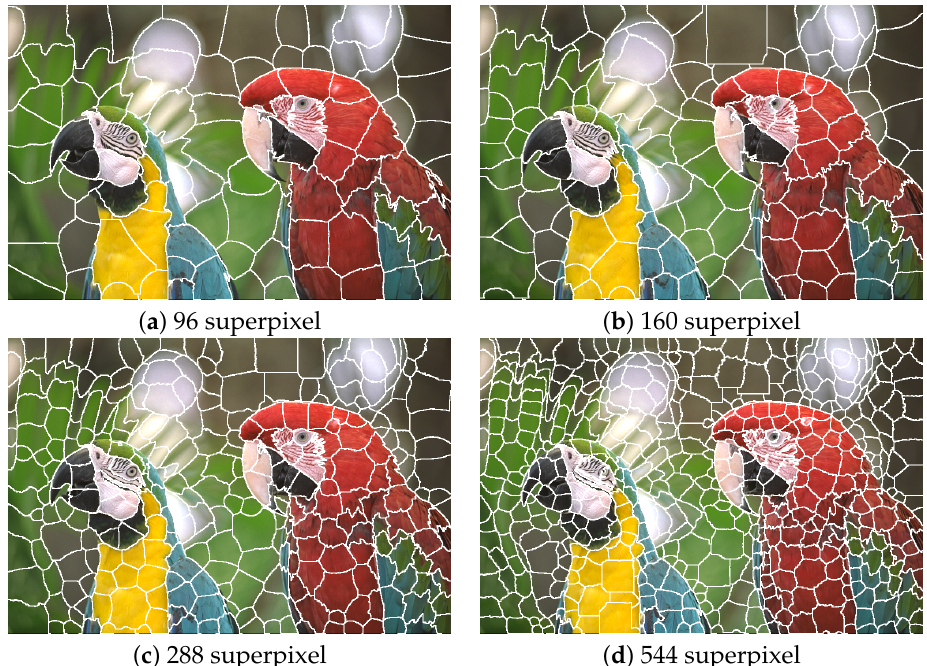
544 superpixels were generated from the source image.